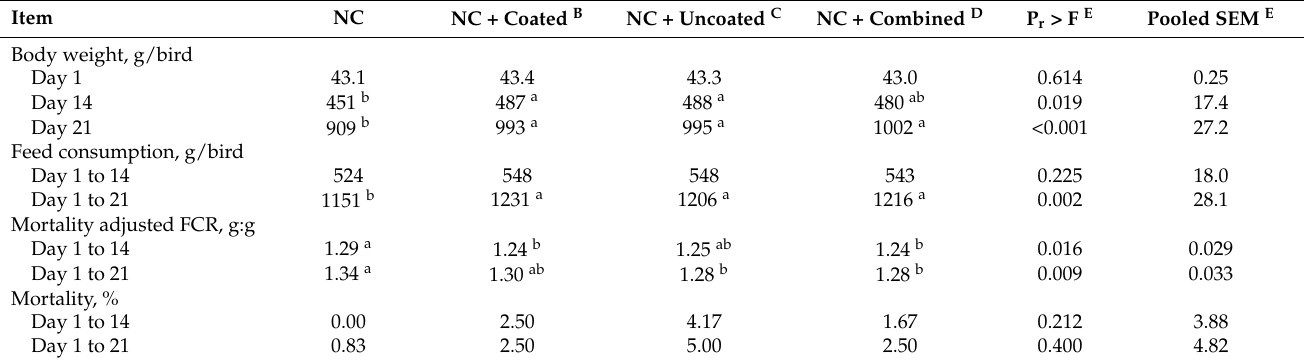
Table 3. Influence of negative control (NC), coated phytase supplementation (NC + 1000 FTU A